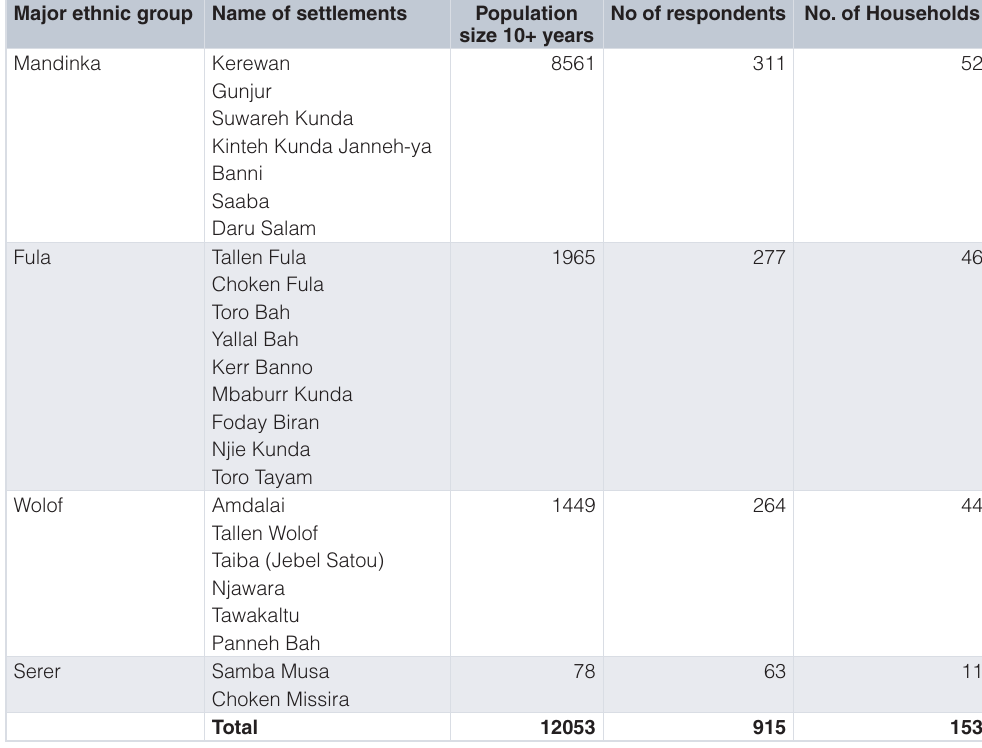
Table 1. Sample size determination by probability proportional to population size. Major ethnic group Name of settlements